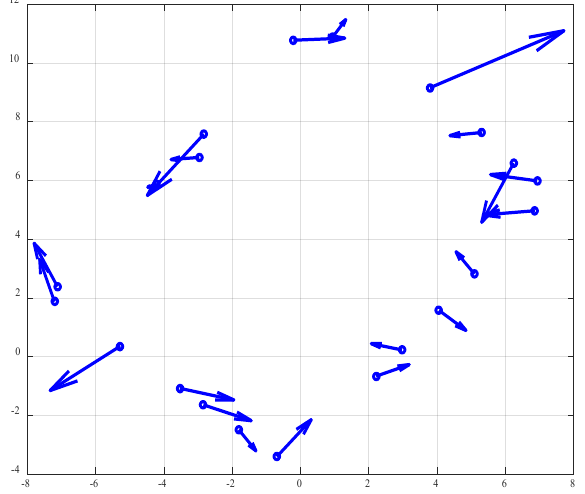
Figure 7. Vector plot of control targets coordinates deviations after transformation Figure 9. Current view of the Quincy Mine Hoist Engine The last mining was performed in 1945 and shaft was closed.